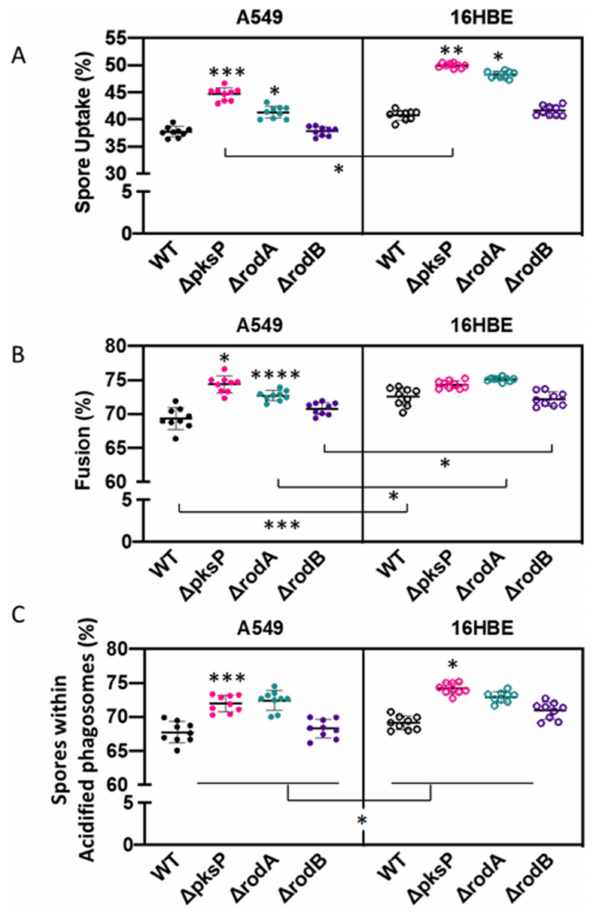
Figure 6. Impact of A. fumigatus cell wall mutants in ( A ) spore uptake, ( B ) phagolysosome fusion and ( C ) phagosome acidification of A549 and 16HBE airway epithelial cells at 3 h post-infection. Asterisks represent differences vs. wild type for each mutant within cell lines. Lines represent differences between cell lines for each mutant. Data shown as mean ± standard deviation of three biological replicates assayed in technical triplicates (* p < 0.05, ** p < 0.01, *** p < 0.001, **** p <